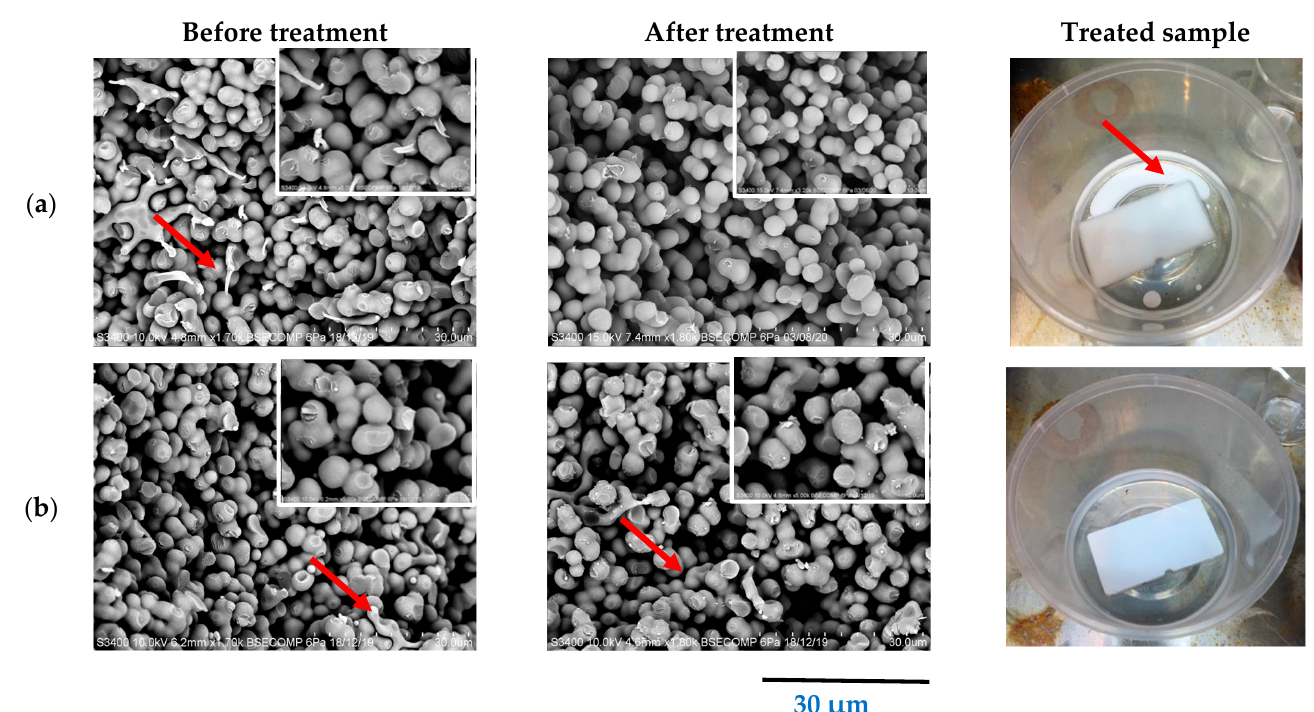
Figure 5. Physical observation and SEM images of monolith before and after template removal process via ( a ) solvent treatment and ( b ) thermal treatment. Red arrows indicate the microsphere template.